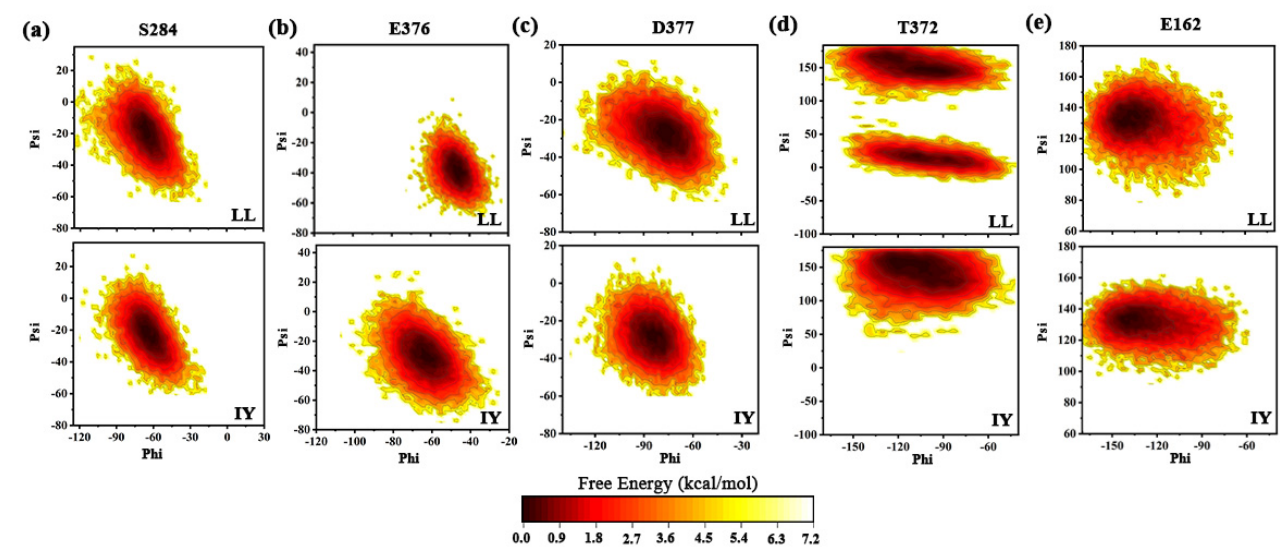
Figure 12. Contour plots of free energies as a function of the backbone angles of φ and ψ for the residues ( a ) E284, ( b ) E376, ( c ) D377, ( d ) T372, and ( e ) E162 of the ACE–LL and ACE–IY complexes. Apo means ligand-free protein, ACE–LL represents the complex system of protein and dipeptide Leu-Leu, ACE–IY stands for complex system of protein and dipeptide Ile-Tyr.